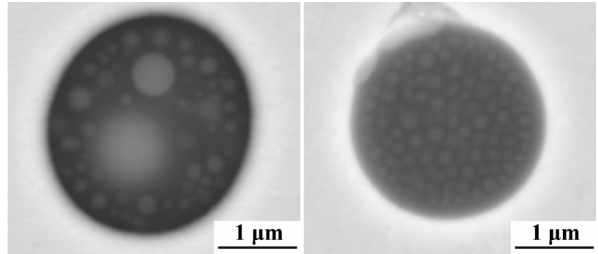
Figure 13: Backscattered electron image of typical K 2 O-Al 2 O 3 -SiO 2 - MnO inclusions in Heat g after cooling in